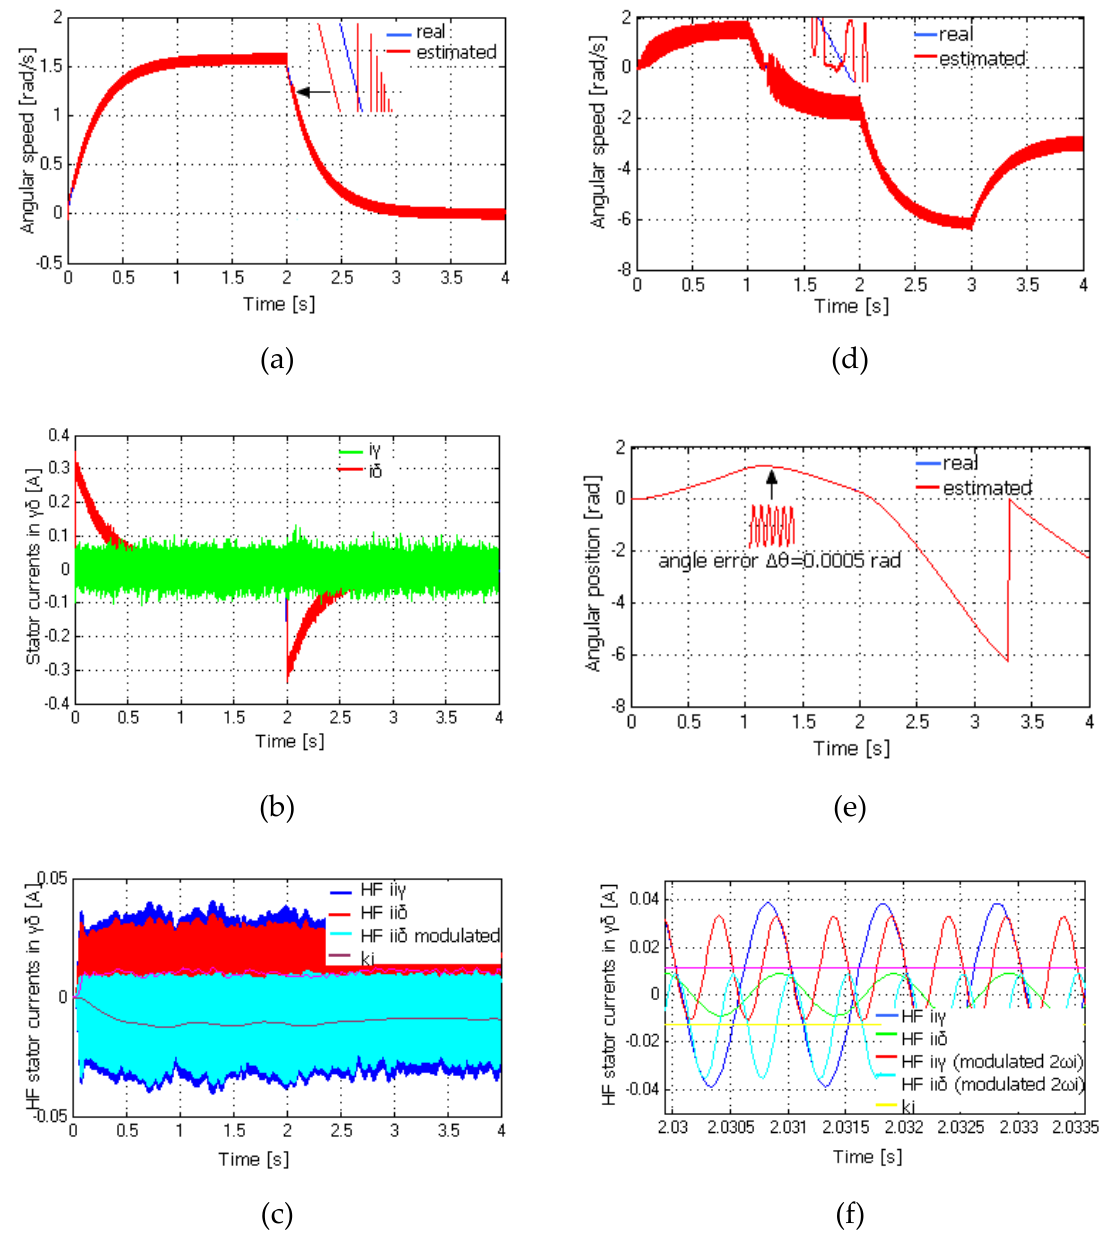
Figure 7. (Left) PMSM responses for speed change from 0 rad / s to π / 2 rad / s (0.25 Hz) and at t 2 = 2 s from π / 2 rad / s to 0 rad / s without external torque: ( a ) angular speed, ( b ) stator current and ( c ) HF stator currents with estimation of k i parameter. (Right) PMSM responses for speed change from 0 rad / s to π / 2 rad / s (0.25 Hz) and at t 2 = 2 s from π / 2 rad / s to – π rad / s (–0.5 Hz), while an external torque of 1 Nm is applied at t 1 = 1 s and removed at t 3 = 3 s: ( d ) angular speed, ( e ) angular position and expansion of HF stator currents with estimation of k i parameter in ( f ).